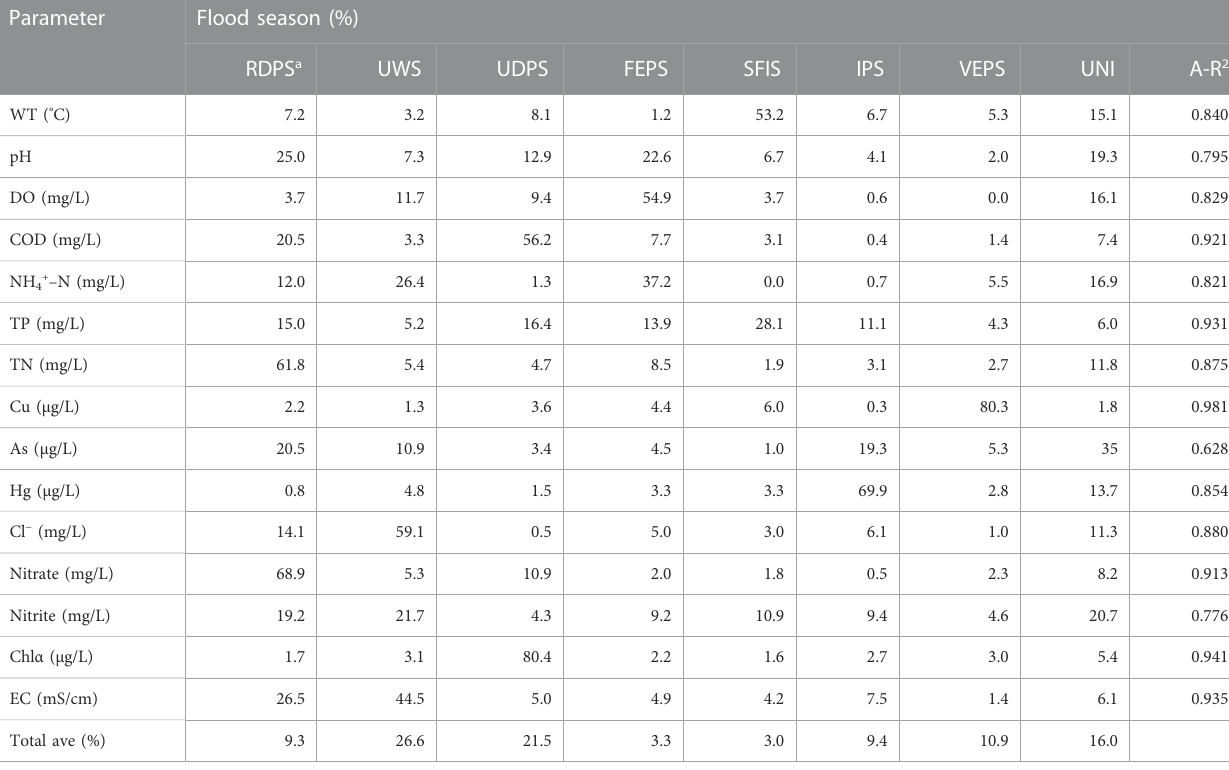
TABLE 3 Contribution of pollution sources for each pollutant in the fl ood season with PCA/FA results. Parameter